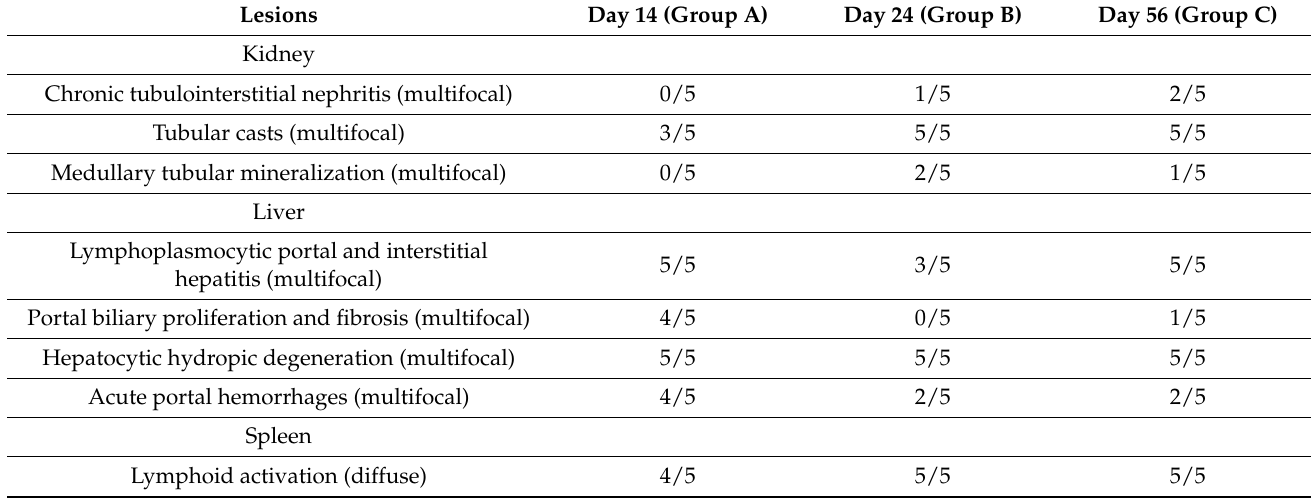
Table 2. Histopathological lesions on days 14, 24, and 56 post